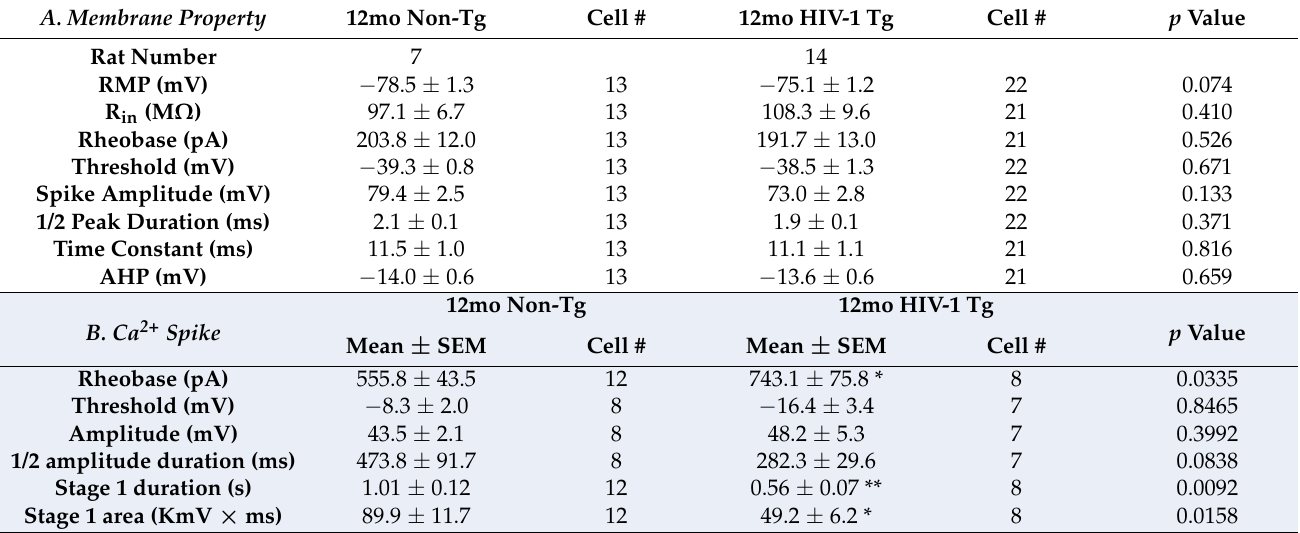
Table 1. The impact of neuroHIV on functional activity of striatal